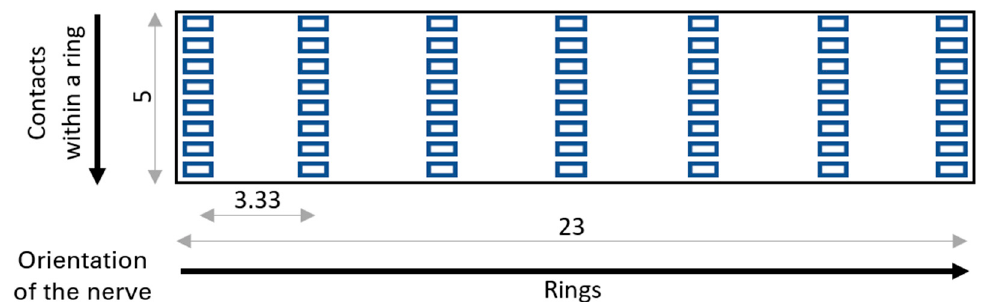
Figure 2. Visualization of the unrolled nerve cuff electrode design used in modelling, with dimensions shown (millime- ters).